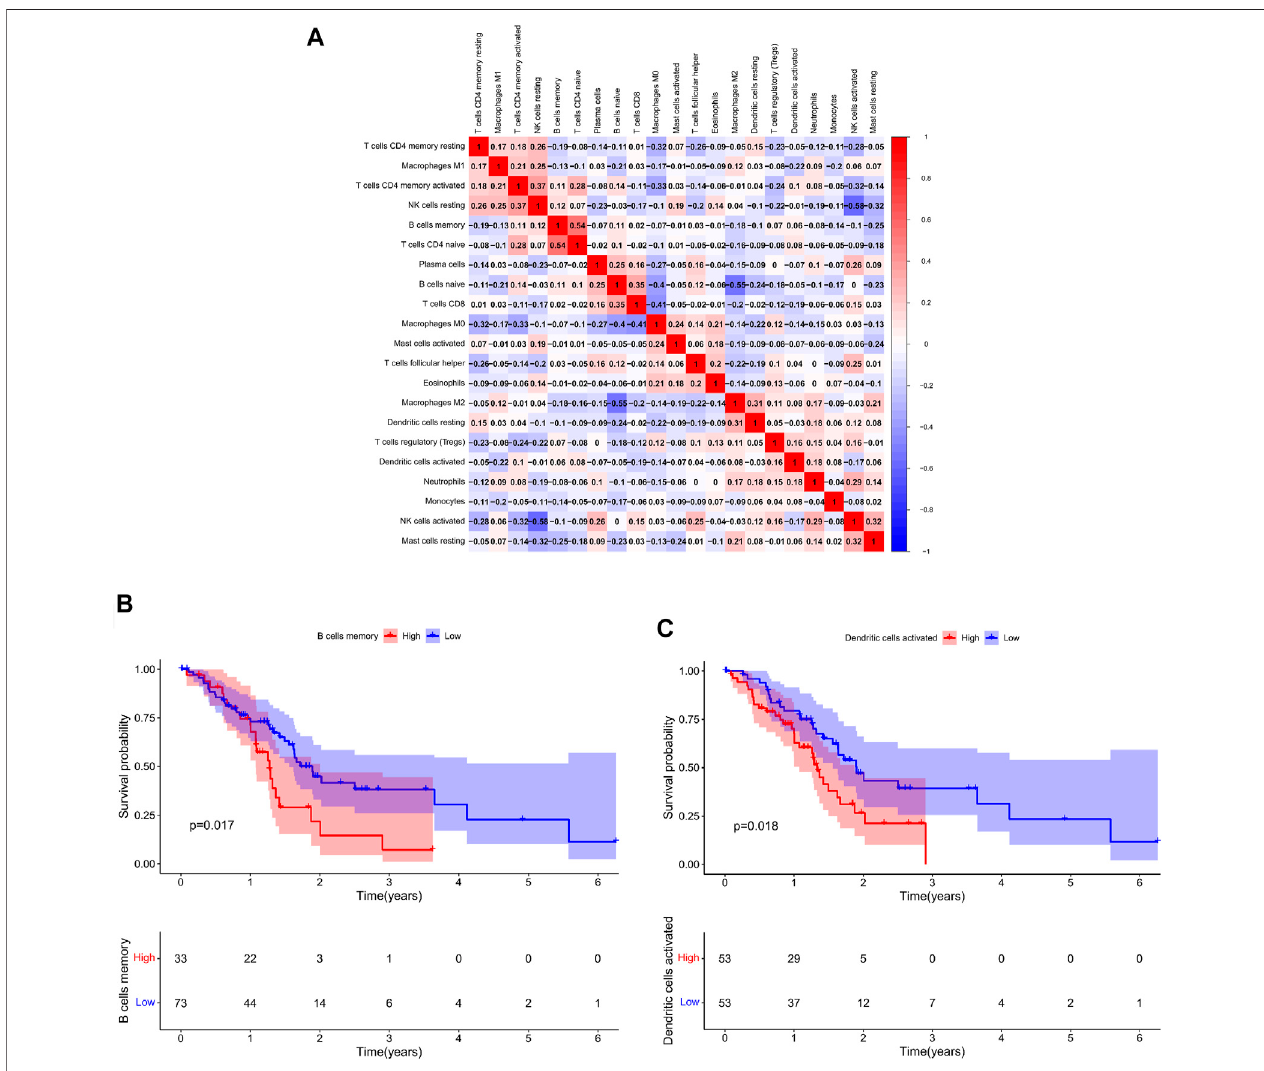
FIGURE 8 | (A) : Co-expression patterns among fractions of immune cells; Kaplan – Meier survival curves of fractions of memory B cells (B) and activated dendritic cells (C) .